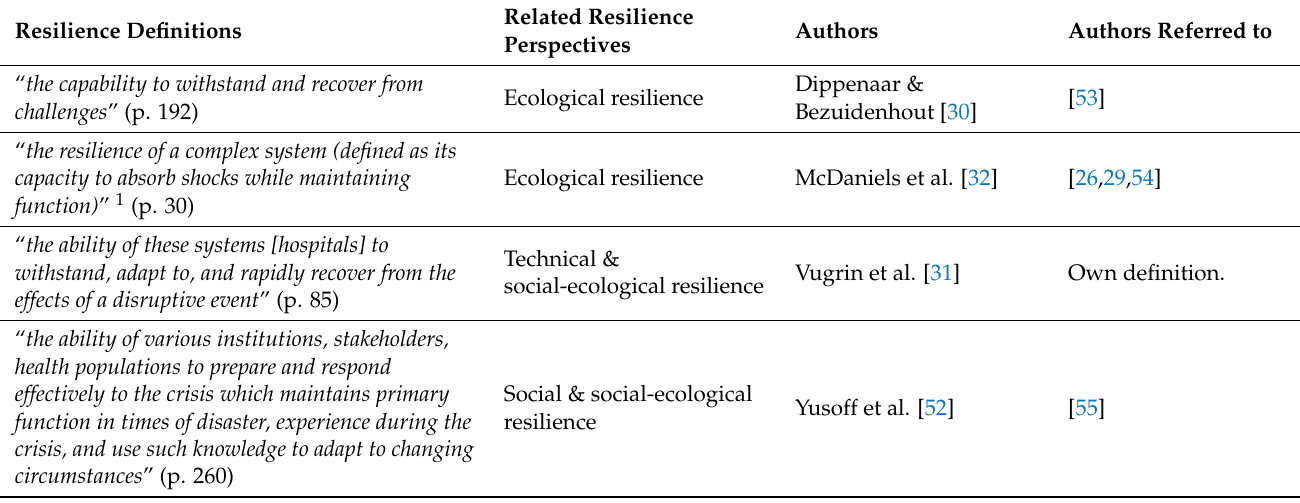
Table 1. Resilience understandings in the critical health infrastructure literature from the review. The “related resilience perspectives” column indicates which resilience understandings the authors refer